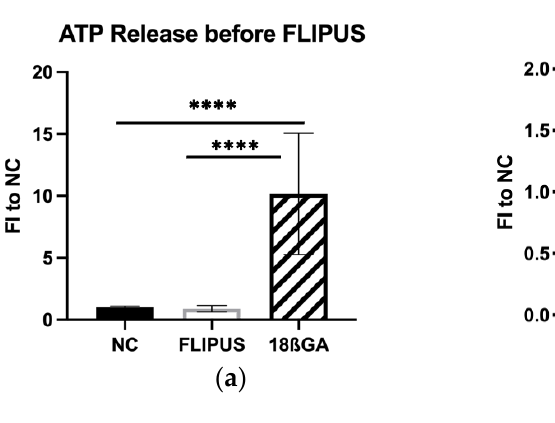
Figure 9. ATP release by starved MLO-Y4 osteocytes after the 10 min stimulation with FLIPUS: ( a ) Quantification results of ATP released in the medium before the FLIPUS stimulation and released by cells treated with 18ß-glycyrrhetinic acid (18ßGA); ( b ) Quantification results of ATP in the medium after the FLIPUS stimulation. FI to NC stands for fold induction over negative control, which did not receive ultrasound treatment. Each data point was the result of N = 3 and n = 3, where N and n are biological trials and technical replicates, respectively. ** and **** represent p ≤ 0.01 and p ≤ 0.0001, respectively .